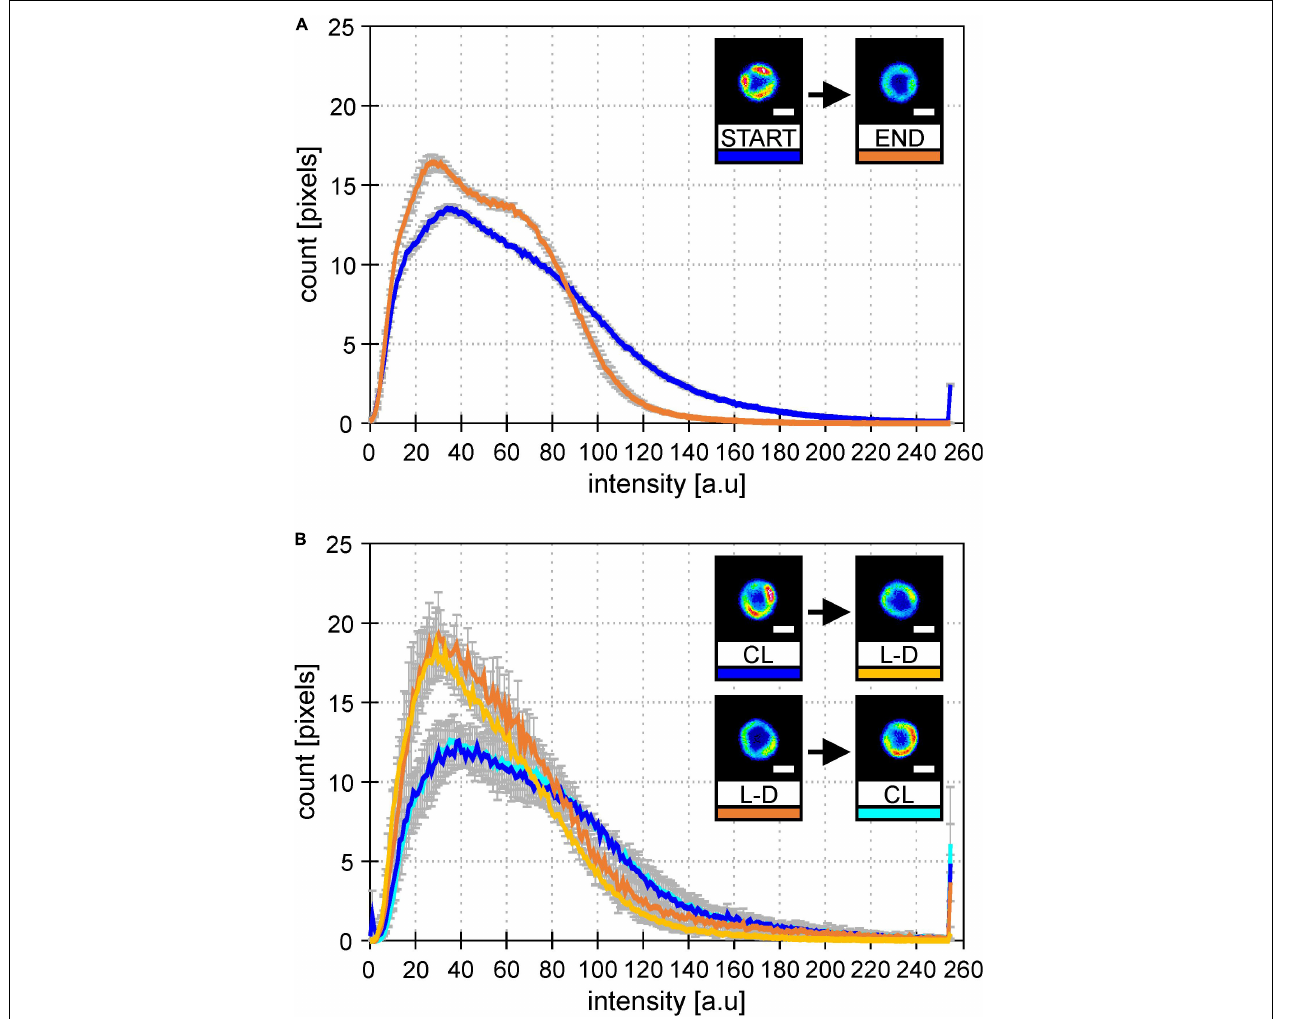
FIGURE 4 | Histograms of PSI-YFP fluorescence intensities from thylakoids of Synechocystis PSI-YFP cells. Figures describe distribution of the PSI-YFP fluorescence intensity in cells grown either on continuous light (“CL”) or at light-dark cycle (“L-D”) in bioreactor and in flask. Histograms represent intensity profiles obtained from 615 (A) and 4276 (B) cells. Scale bars in the pictures show 1 µ m. Total number of cells analyzed per day was n = 947. (A) Bioreactor data: Figures depicts distribution of PSI-YFP fluorescence intensities at the start (blue; days 2 and 3) and the end (orange; days 13 and 14) of bioreactor experiment. The pictures show typical PSI-YFP thylakoid distribution in cells from the START (cells acclimated to continuous light) and the END (cells acclimated to day–night cycle for 2 weeks) of bioreactor experiment. (B) Erlanmeyer flask experiment: Plots of PSI-YFP fluorescence intensity distribution for cells grown in the flask at continuous of light-dark cycle. Histograms and figures describes two experiments: (1) cells grown for 10 days on the continous light (“CL”; blue) were moved into the light-dark condition for 10 days (“L-D”; yellow); (2) cells grown in the light-dark condition (“L-D”; orange) for 10 days were moved into continous light (“CL”;